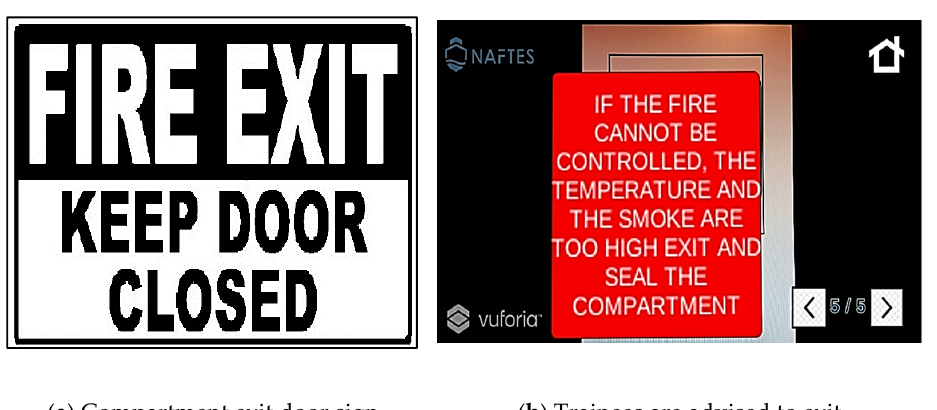
Figure 5. Fifth screen of a scenario of fire on an electrical circuit. ( a ) Printed target sign, and ( b ) the corresponding instruc- tions that appear in the firefighters’